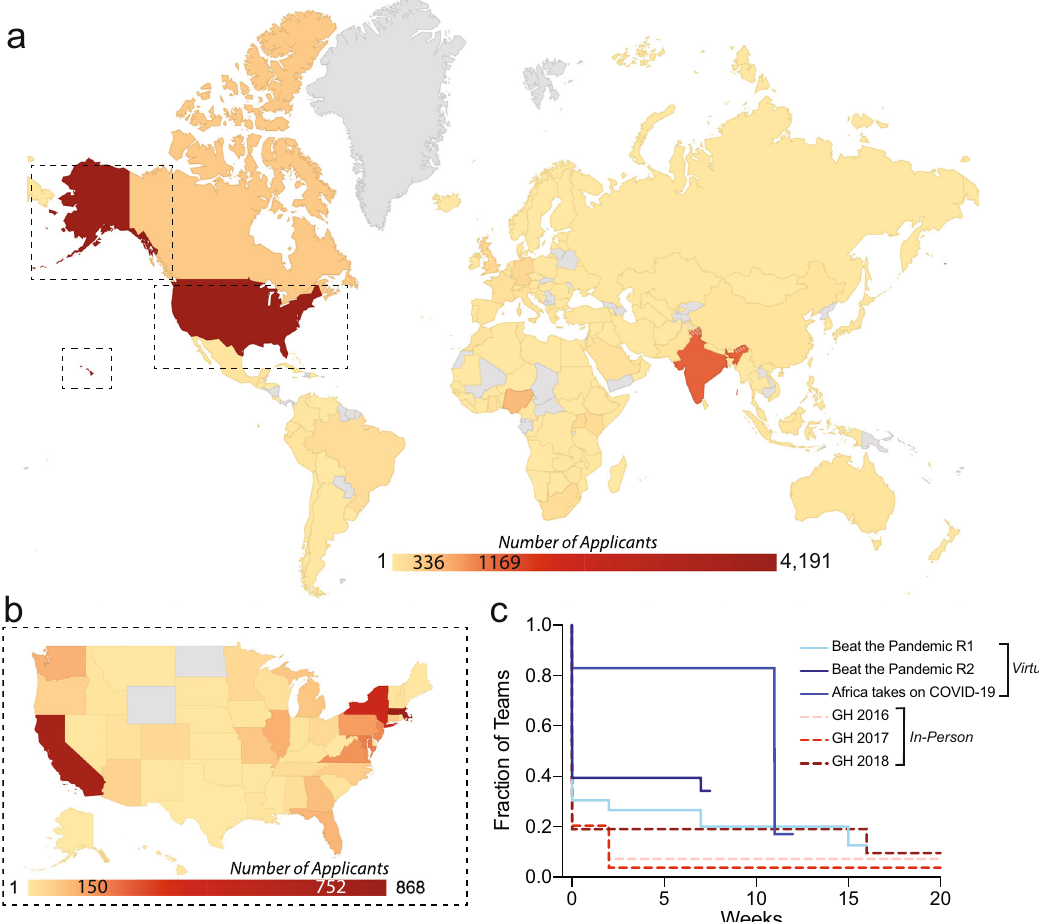
Fig. 1 Worldwide crowdsourced innovation. a , b Number of applicants per ( a ) country around the world and ( b ) state in the US for MIT COVID-19 Challenges. Gray color shading corresponds to no applicants from that country. c Fraction of teams continuing to work on their ideas post-event. Plots show team continuation for teams from recent virtual events and in-person events in 2016, 2017, and 2018 (GH, Grand Hack). Maps generated using Google GeoChart API under Creative Commons Attribution 4.0